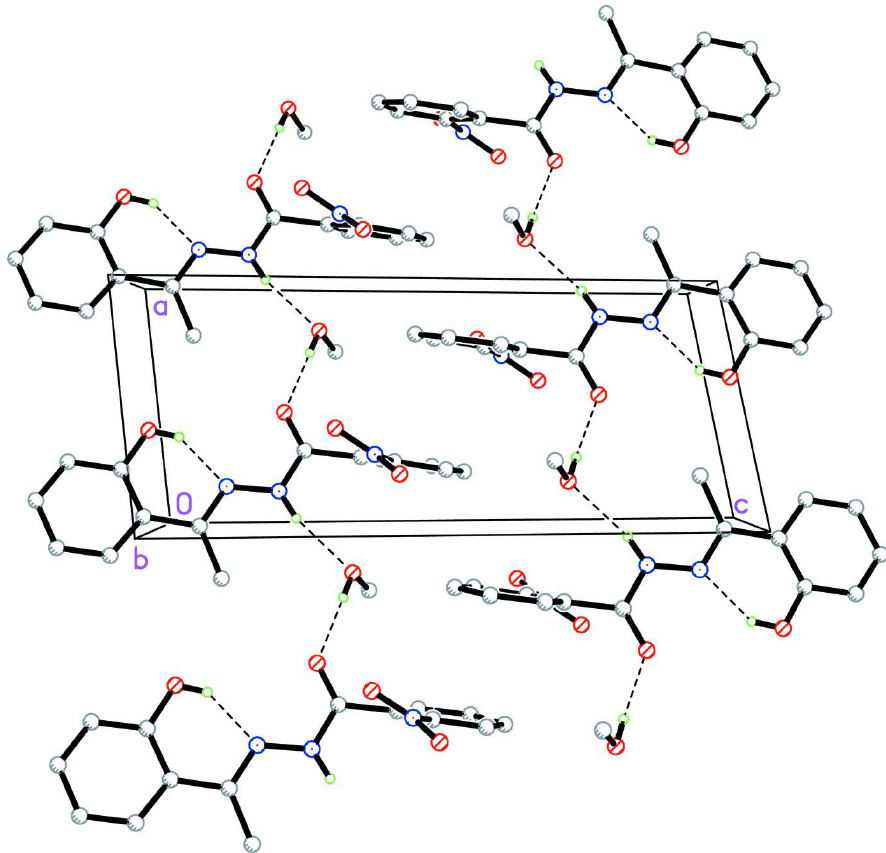
Hydrogen-bonded (dashed lines) chains in the title compound, viewed along the b axis. H atoms not involved in the interactions have been omitted for